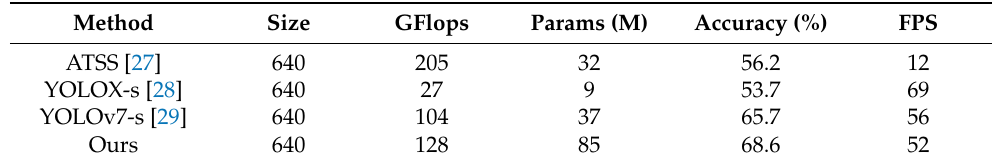
Table 11. Comparison with the results of other target detection